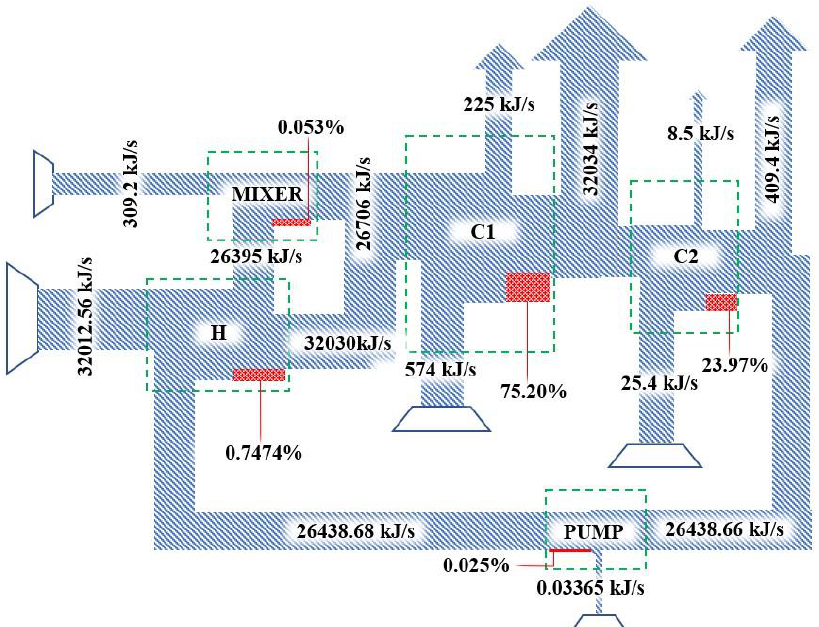
Figure 2. Exergy balance in the process of obtaining fuel ethanol (the boxes in red show the percentage contribution to total exergy, the green stripes are the control volume to which the exergy balance is applied and the blue arrows are the exergy currents of the process). Source: the authors.